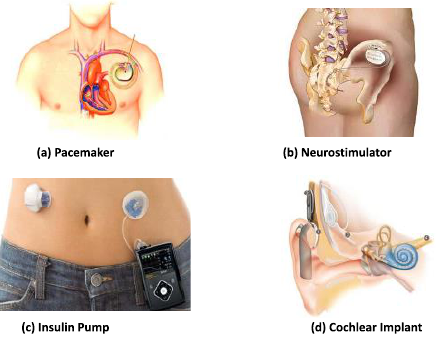
Figure 11. Implantable medical devices: ( a ) An artificial pacemaker implanted in a patient’s chest with electrodes contacting heart muscles. ( b ) A Medtronic InterStimneuro-stimulation device for sacral nerve stimulation therapies. ( c ) A semi-implanted insulin pump monitors current glucose levels and delivers proper amount of insulins continuously. ( d ) A cochlear implant helps patients suffering hearing loss [75]. Reprinted with permission from ref. [75]. 2016 Institute of Electrical and Electronics Engineers.